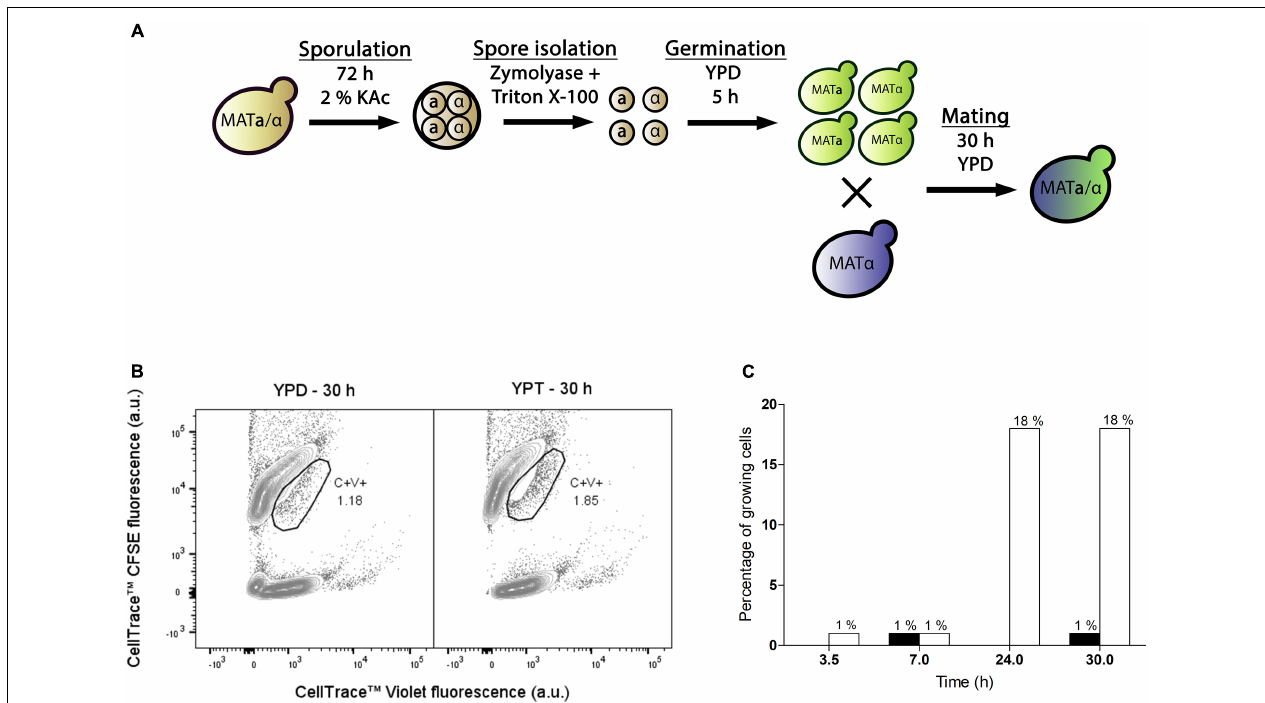
FIGURE 2 | Optimization of interspecies hybridization between haploid S. eubayanus and S. cerevisiae strains. (A) Overview of the optimized protocol for interspecies spore-to-cell mating. (B) Fluorescence contour plots of mating cultures of stained CBS 12357 spores and IMK439 cells after 30 h of mating on YPD and YPT. The gated areas were used for sorting cells, event rates of each gate are indicated as a percentage. (C) Percentages of cells in the double-stained population able to grow on SM+G418 after 3.5, 7, 24, and 30 h of incubation on YPT (black) and YPD (white). Mating on YPT was only assessed at 7 and 30 h.